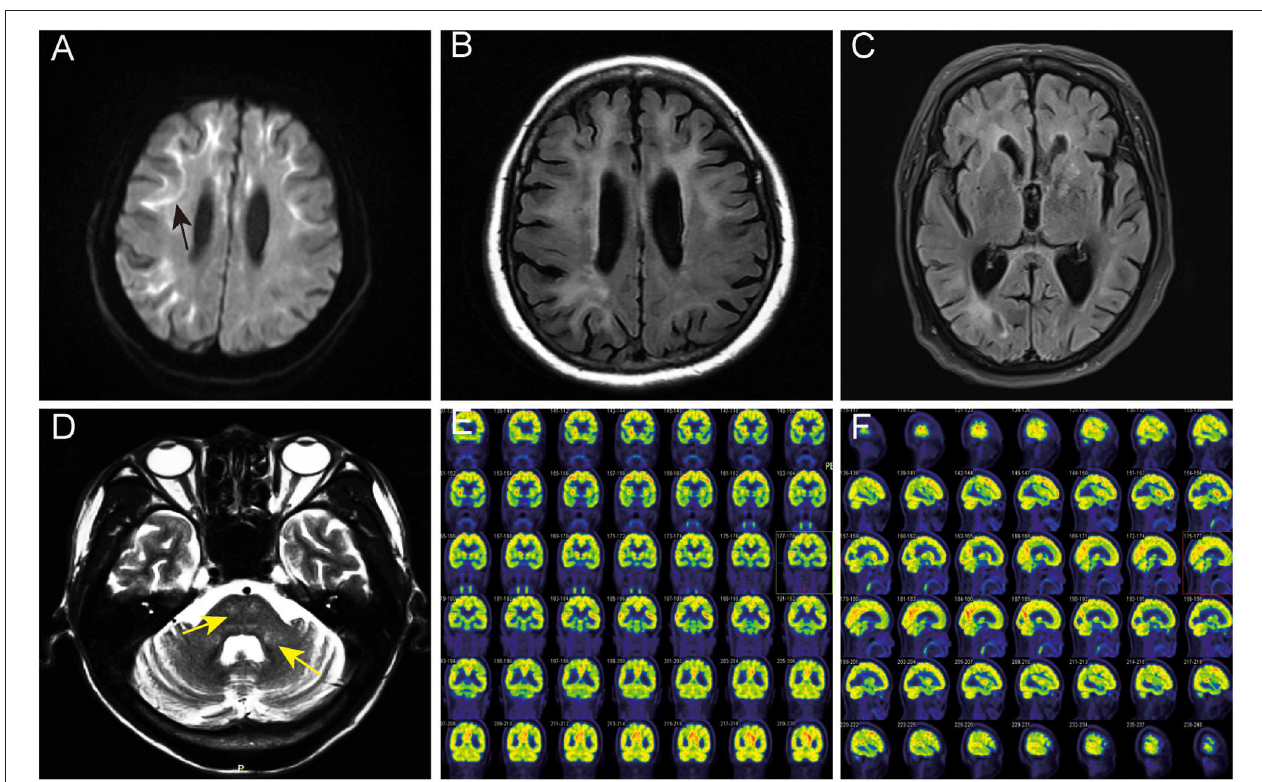
FIGURE 1 | Head MRI and PET-CT findings of NIID cases. (A) The linear high signals on DWI of subject 2 in the corticomedullary junction (black arrow). (B) Bilateral paraventricular white matter hyperintensity on T2 FLAIR of subject 2. (C) Ventricular dilation on T2 of subject 2. (D) Hyperintensity areas in the cerebral pontine and the middle cerebellar peduncles on T2 FLAIR (yellow arrow). (E,F) The 18 F-FDG PET-CT of subject 2 showed decreased metabolism in the left frontal lobe and right parietal